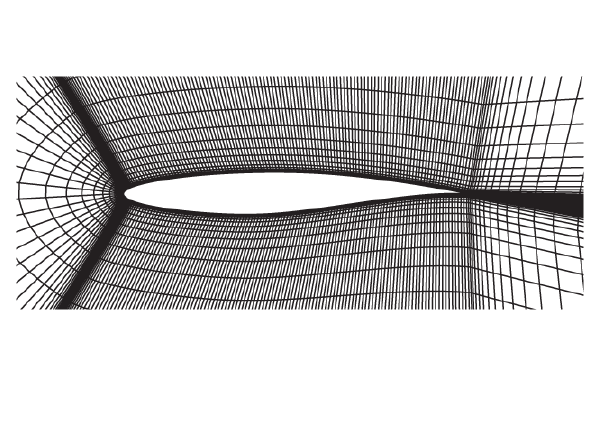
Figure 3: Partial view of the coarse grid used for the computations.